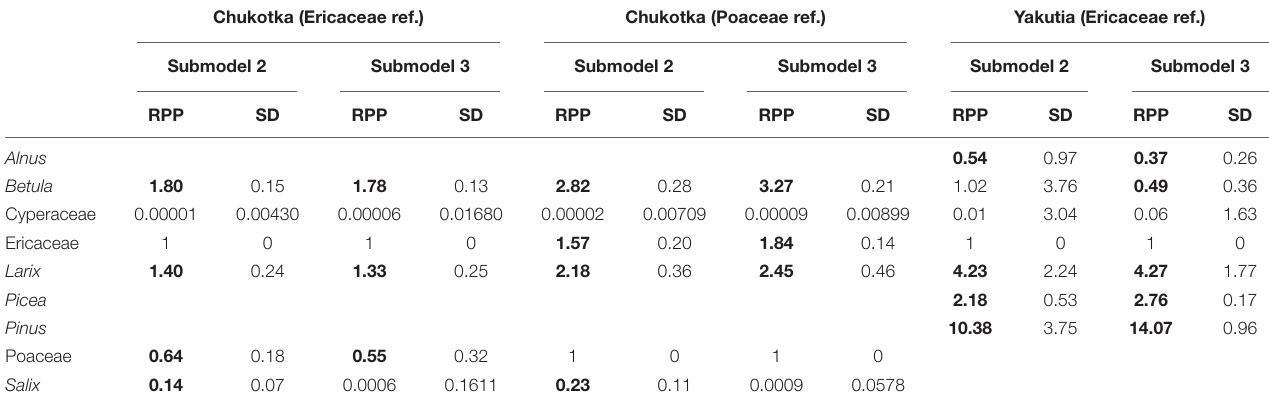
TABLE 4 | Relative pollen productivity (RPP) estimates and standard deviations (SDs) for selected taxa in Chukotka and central Yakutia. Chukotka (Ericaceae